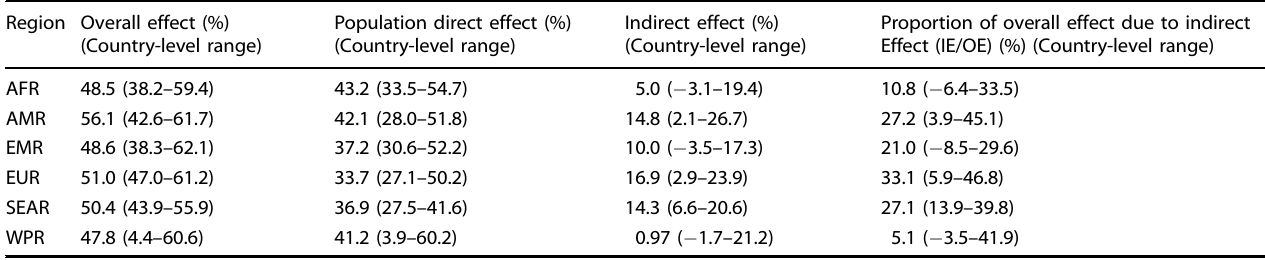
Table 1. Median percent of rotavirus deaths averted 8-years post-vaccine introduction to due vaccine effects. Region Overall effect (%) Population direct effect (%) Indirect effect (%) (Country-level range) (Country-level range) (Country-level